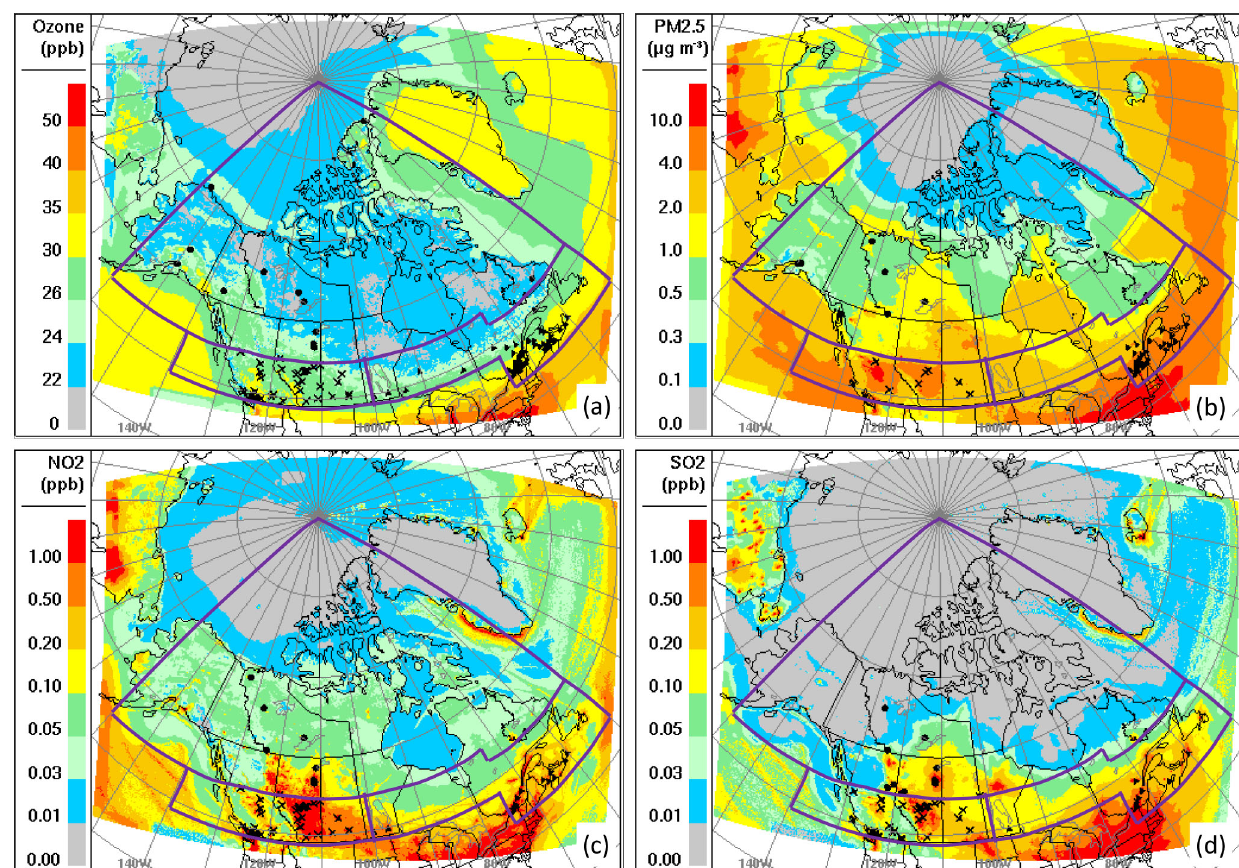
Figure 3. GEM-MACH Arctic modelling domain overlaid with monitoring sites: (a) O 3 monitoring sites shown on top of the modelled average ambient concentration over the July–September period; (b) the same as (a) but for PM 2 . 5 ; (c) the same as (a) but for NO 2 ; (d) the same as (a) but for SO 2 . (Subdivision of regions: crosses denote the sites in the western region, filled triangles denote the sites in the eastern region, and filled circles denote sites in the northern